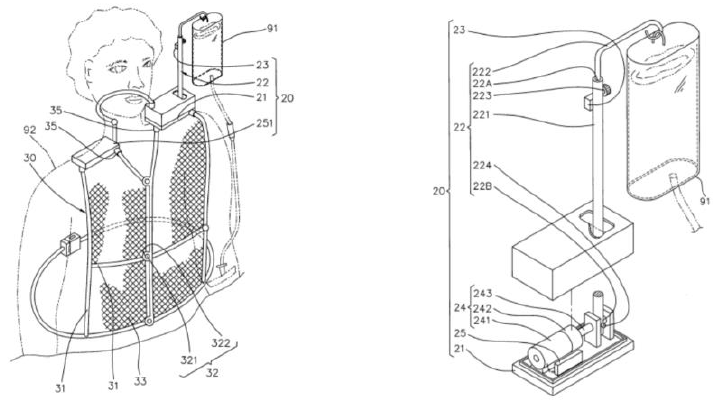
Figure 1. The conceptual system architecture [7].